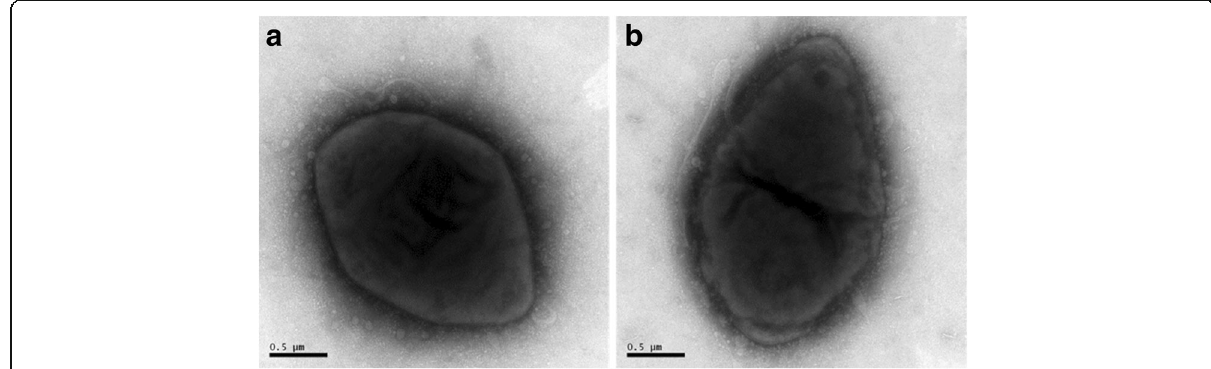
Fig. 1 Transmission electron micrographs of Acuticoccus yangtzensis JL1095 T cultured on marine agar 2216 (MA; Difco) medium. a Oval-shaped cells with one peak end; b a cell divided by binary fission. Scale bar, 0.5 μ m